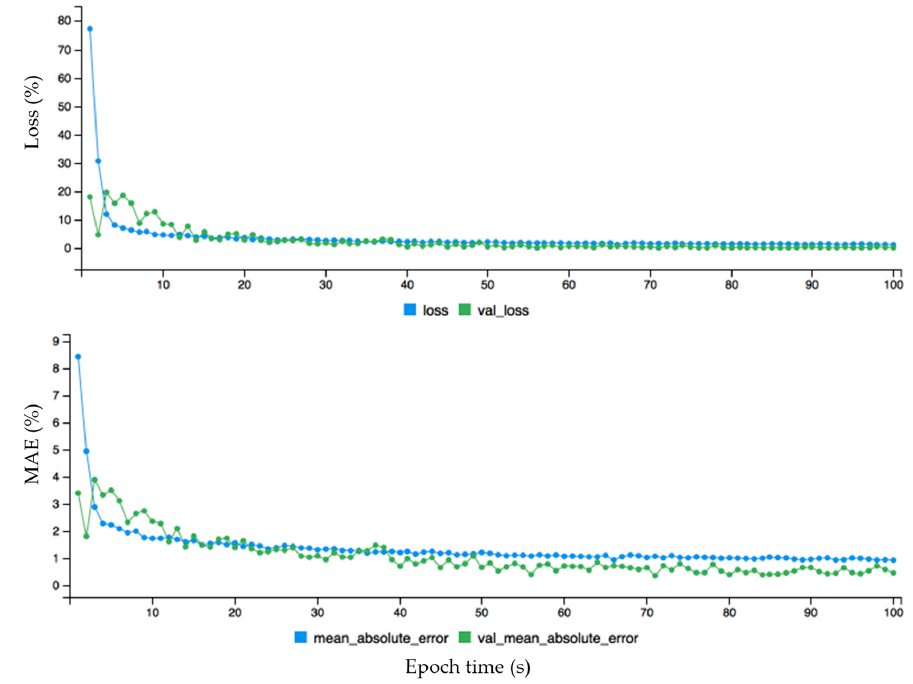
Figure 12. The dynamic plot of forecasting error after fine tuning configuration for annual wind data. Overall, the yearly wind data behave very differently compared to hourly and monthly data. A big difference is shown between the loss and validation curves without fine tuning configuration.